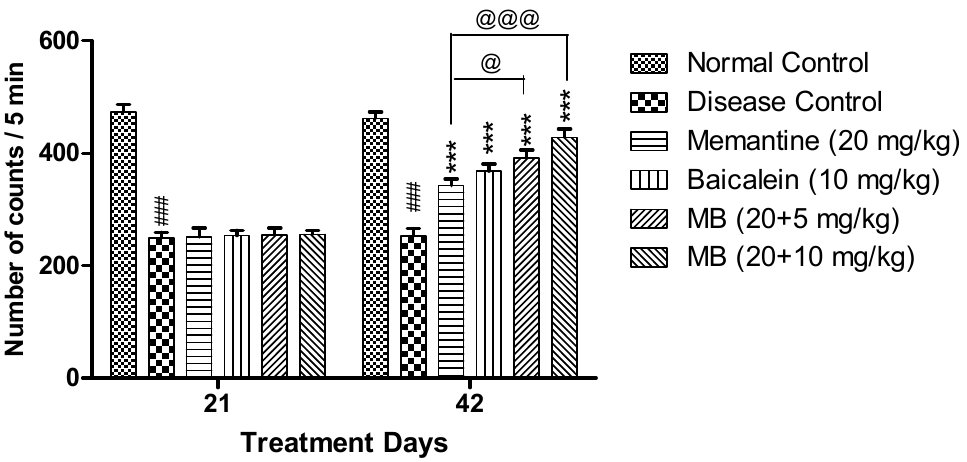
Figure 1. Actophotometer—The locomotor activity of each treatment group was plotted against treatment days (21 and 42 days). Data are shown as mean ± SEM (n = 6) at p < 0.05. Comparison with normal control is indicated with ### p < 0.001, whereas comparison with disease control is indicated with *** p < 0.001; @ p < 0.05 and @@@ p < 0.001 indicate comparison with memantine group. MB: memantine + baicalein.